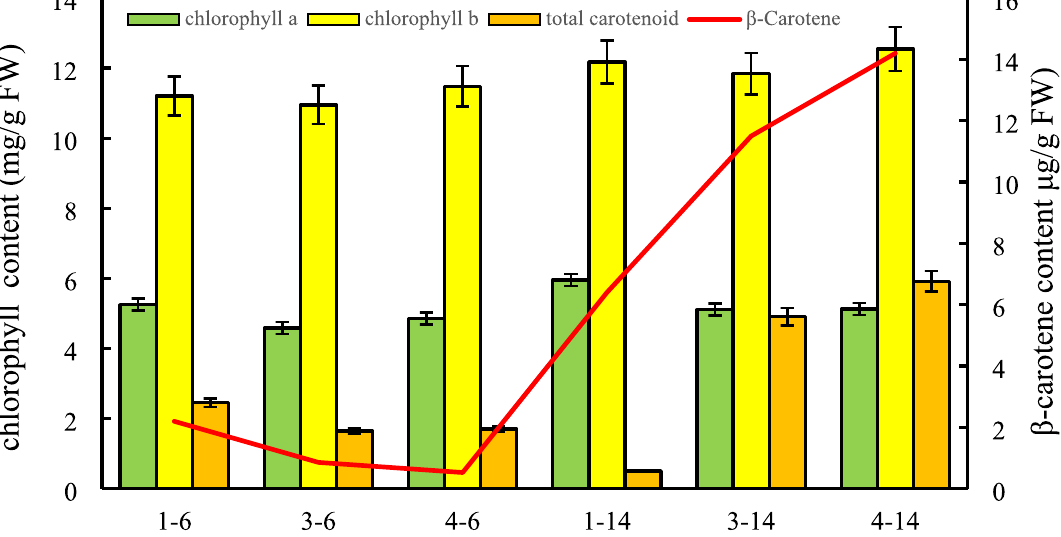
Figure 2. Chlorophyll a (Chl a), chlorophyll b (Chl b), total carotenoid, and β-carotene contents of the two melon cultivars at 10, 30, and 45 d after pollination (DAP); 1-6, 3-6, 4-6, and 1-14, 3-14, 4-14 represent the “B-6” and “B-14” cultivars at 10, 30, and 45 DAP,